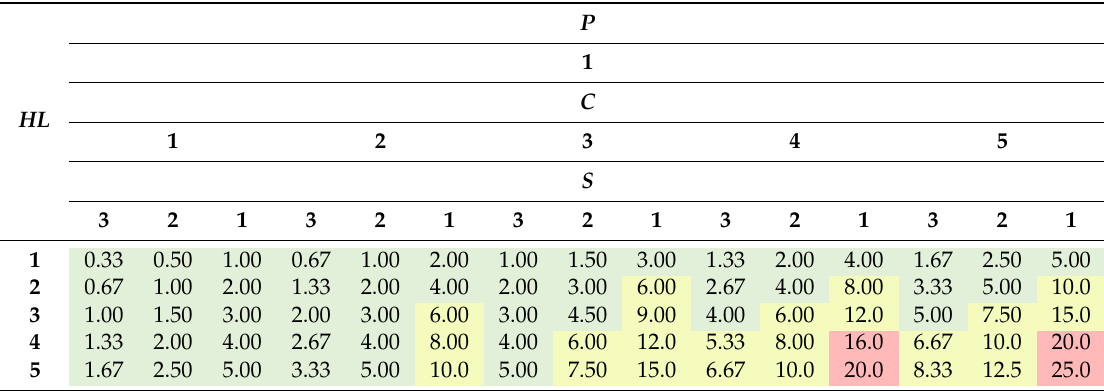
Table 4. The four-parameter